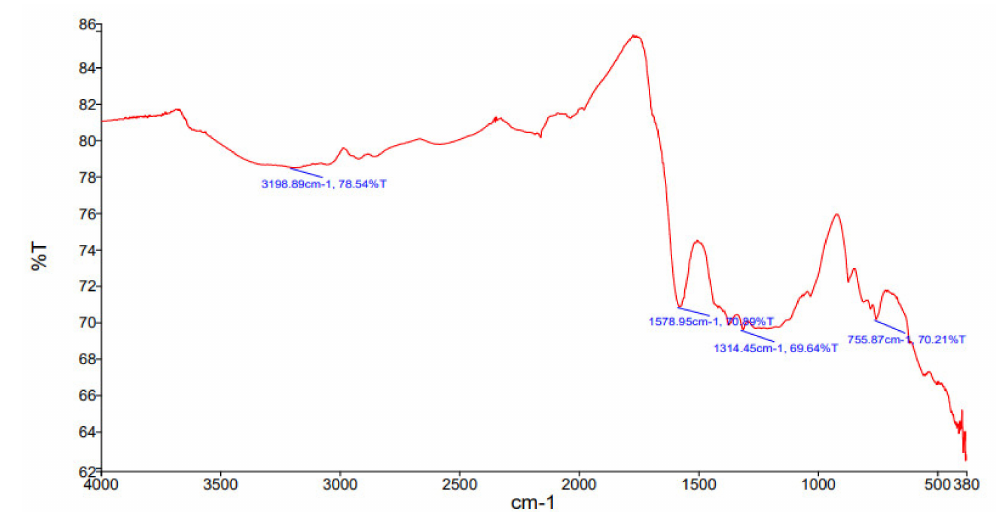
Figure 9. Fourier transform infrared (FT-IR) spectrum of vine waste